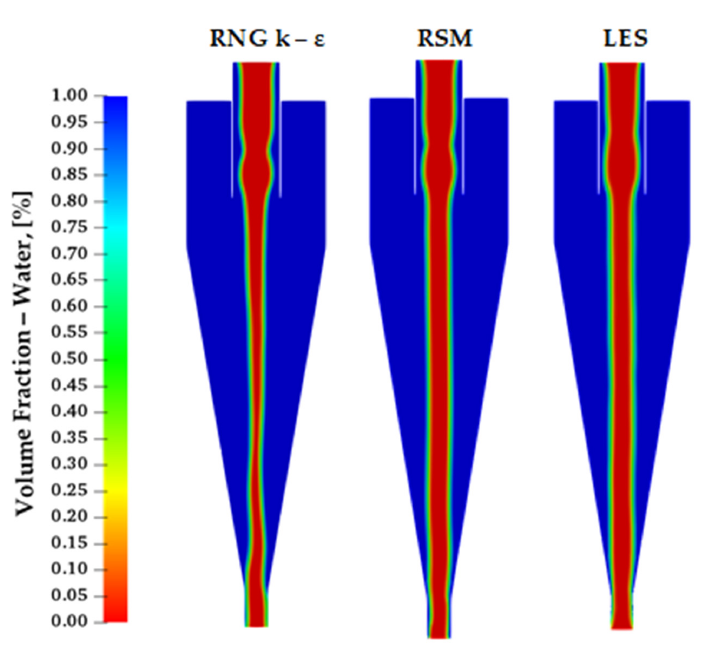
Figure 7. Volume fraction of water contours.